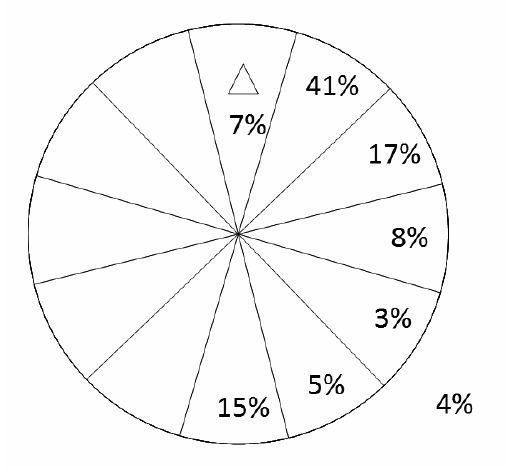
Fig. 2 Distance. Triangle represents respondent’